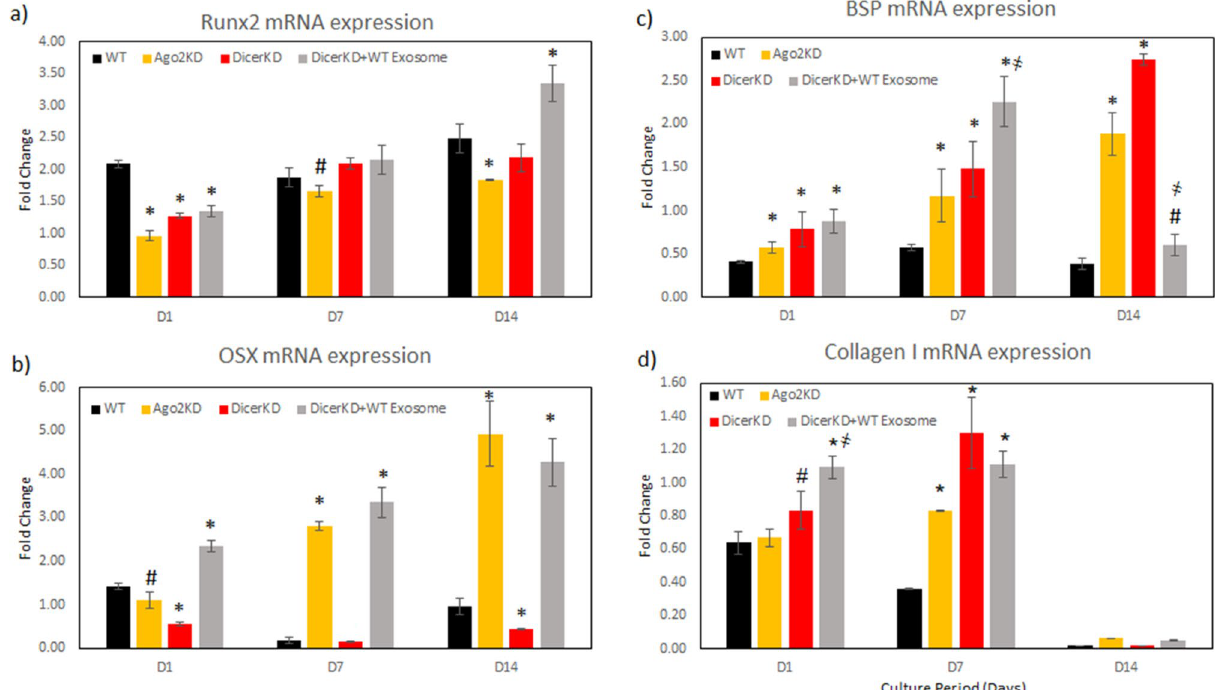
Figure 4. Quantitative gene expression. Expression of osteoinductive genes in WT, DicerKD and AGO2KD hMSCs under differentiation conditions. * denotes to P < 0.01 and # denotes to P < 0.05 in comparison to WT hMSCs. ҂ denotes significant difference ( P < 0.01) compared to DicerKD hMSCs. Fold changes are calculated relative to undifferentiated WT hMSCs at day 0. One-way ANOVA and Tukey’s post-hoc test was used for all statistical analyses.